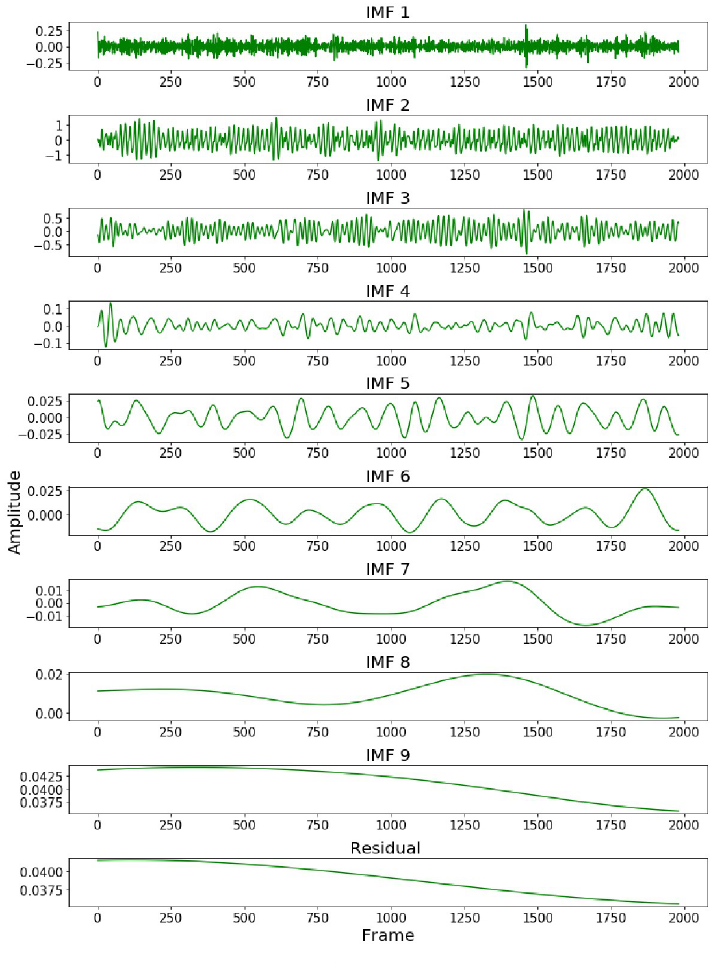
Fig 3. The IMFs and the residual of the filtered